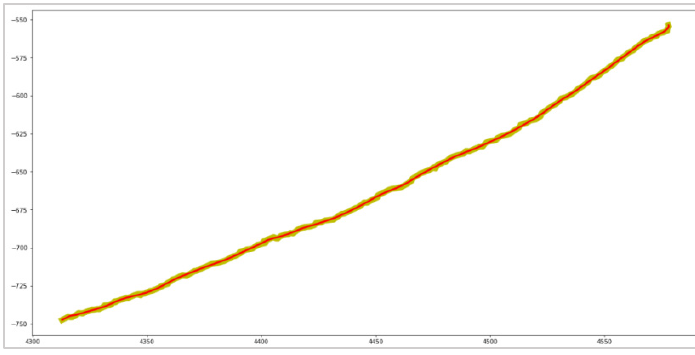
Figure 5. Smoothing process of trajectory.